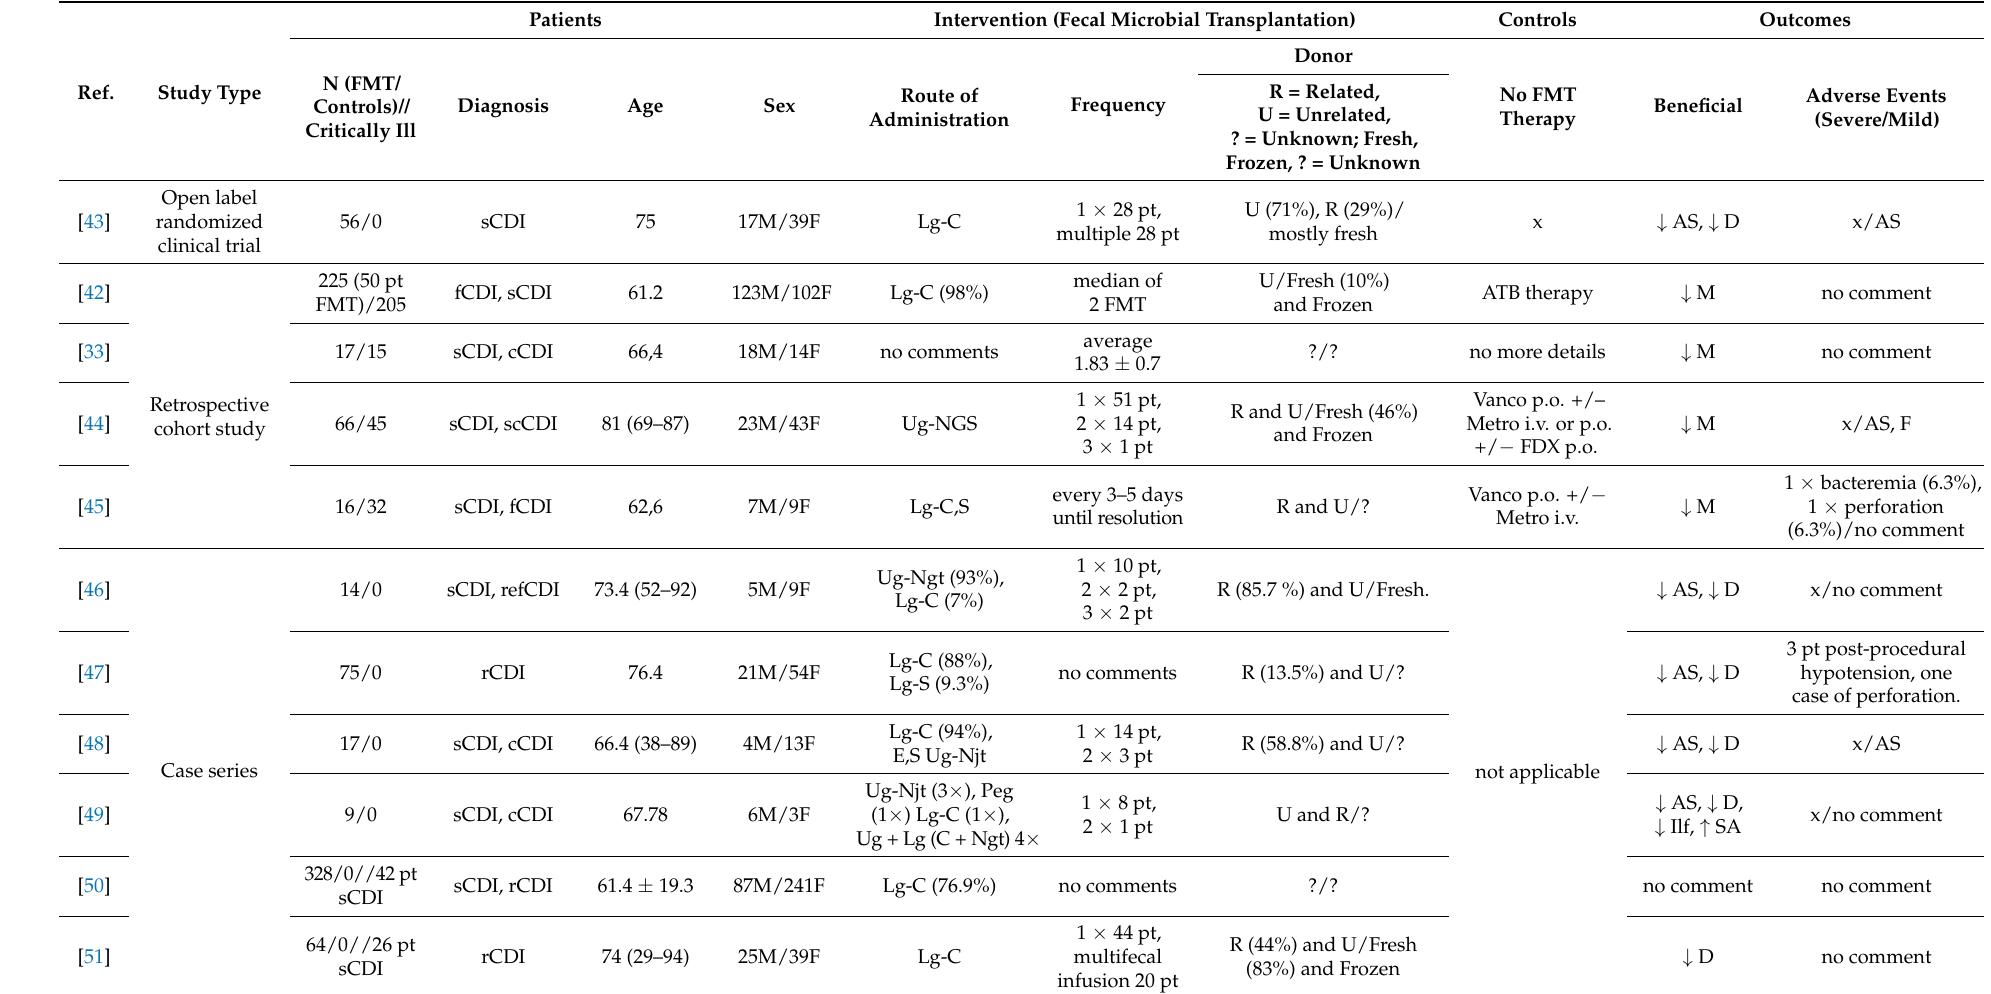
Table 1. Clinical studies on critically ill patients with Clostridium difficile